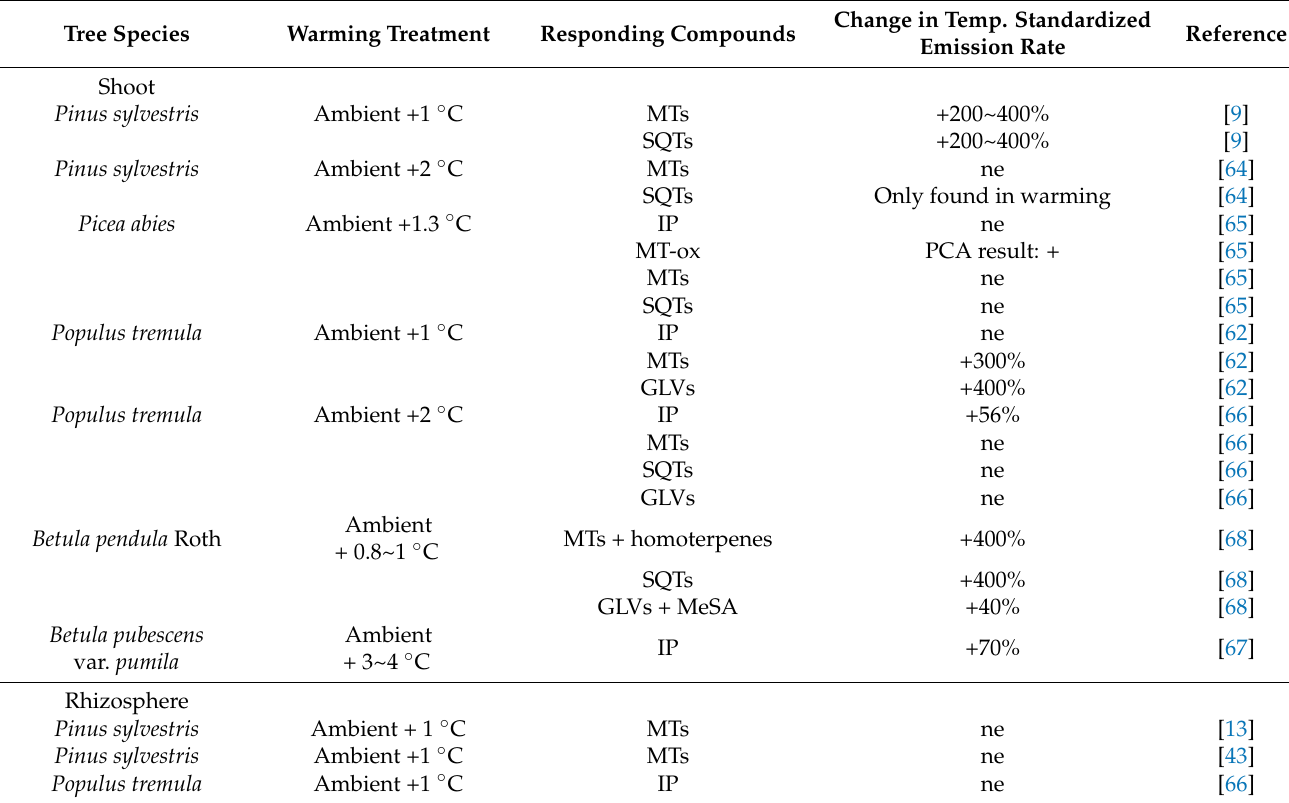
Table 1. Examples of warming impacts on emissions of isoprene (IP), non-oxygenated monoterpenes (MT-no), oxygenated monoterpenes (MT-ox), monoterpenes (MT-no + MT-ox, MTs), sesquiterpenes (SQT), green leaf volatiles (GLV) and Methyl salicylate (MeSA). ‘+’ shows the size of increasing warming effects; ‘ne’ means no warming effects. Tree Species Warming Treatment Responding